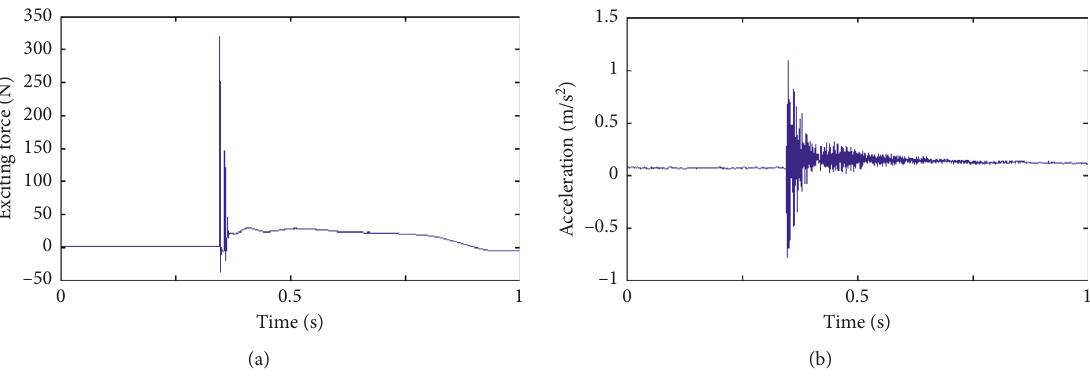
Figure 3: Exciting force and the vibration response.